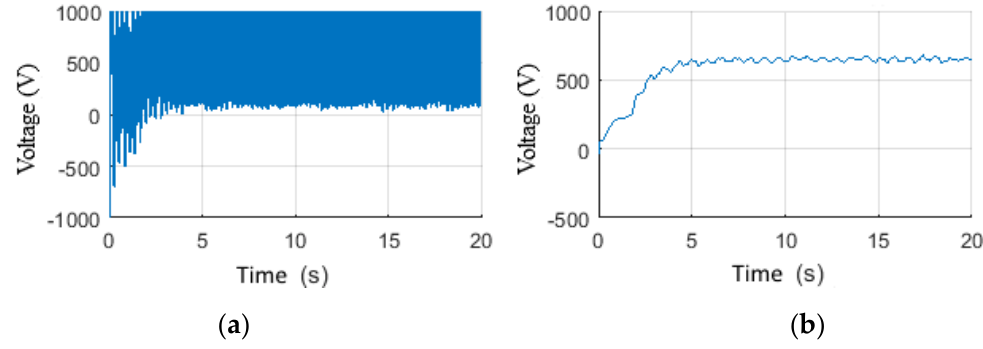
Figure 38. Real and estimated Drill bit velocity with: ( a ) LQG controller, ( b ) H ∞ controller.